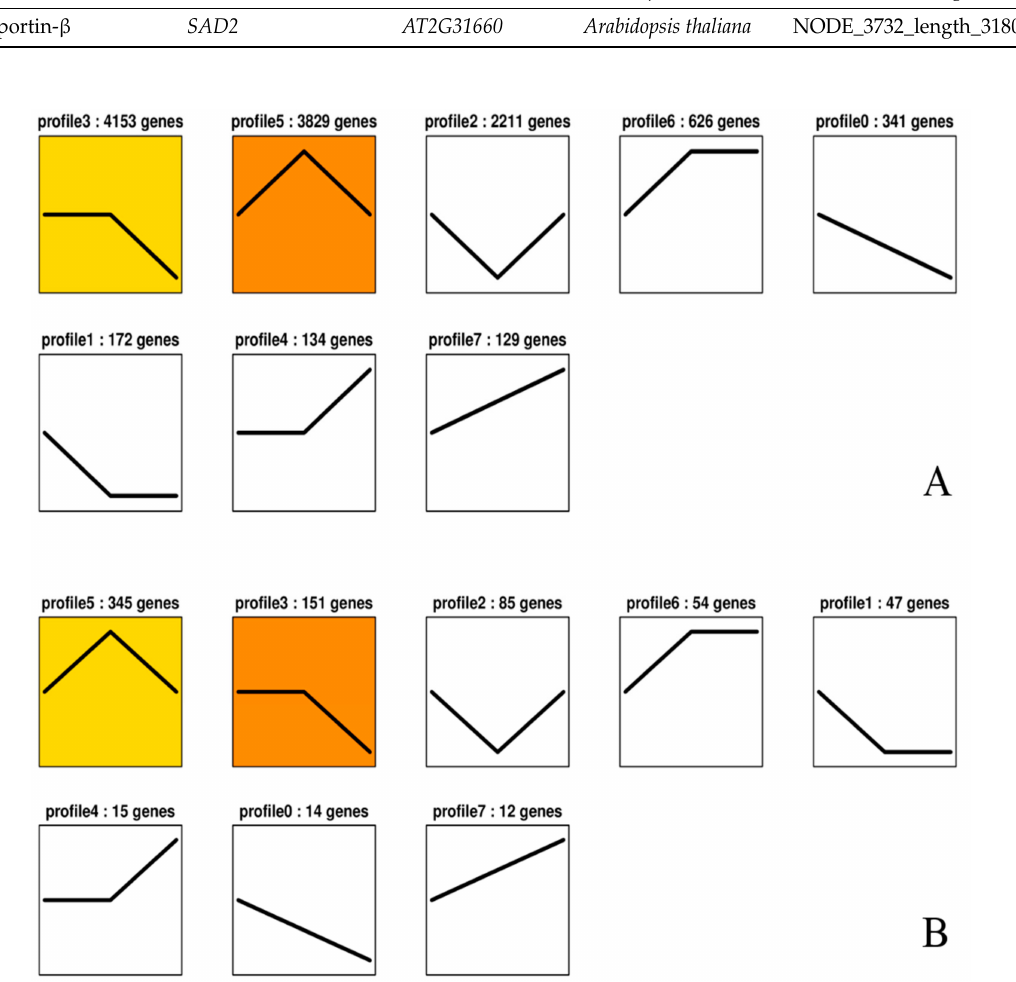
Figure 7. ( A ) Overall trend map of numbers of di ff erentially expressed genes; profile analysis of the union of di ff erential genes. ( B ) Overall trend map of gene numbers displayed by transcription factors; trend analysis of di ff erentially expressed genes annotated as transcription factors. At the top of the graphs are the IDs of the profiles and the numbers of genes in the trends. Graphs with colors show significant enrichment trends, and di ff erent colors distinguish di ff erent trends. The graphs without color show nonsignificant enrichment